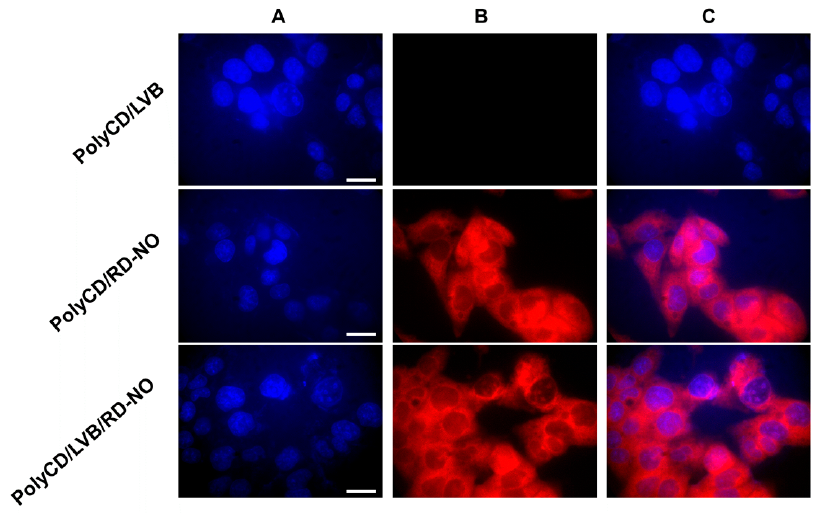
Figure 7. Fluorescence microscopy analysis of HEP-G2 hepatocarcinoma cell lines treated with PolyCD (2 mg mL − 1 ) in PBS (pH 7.4) loaded with LVB (25 µM), RD-NO (6 µM) and both components and stained with DAPI. The cells were analyzed with a DAPI emission filter ( A ), a rhodamine emission filter ( B ), or by merging images ( A , B ) ( C ). Scale bar = 50 µM. Cell mortality experiments were carried out with the above-mentioned cell lines. In a the cell viability as a function of the free LVB concentration in a serum-free medium. Under our experimental condition, the 4 h incubation with LVB did not alter cell viability, and 24 h results, the IC 50 was 132.6 ± 26.8 µ M at 24 h and 572.1 ± 235.6 µ M at 4 h + 24 h (Figure 8).